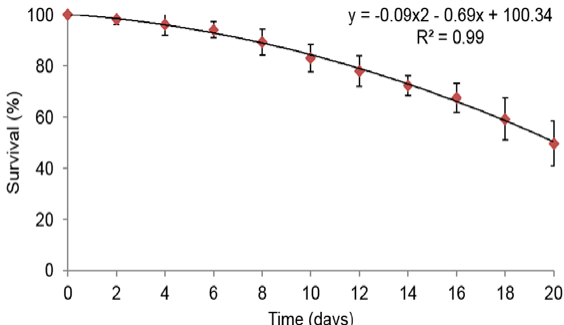
Fig. 5. – Cyprid survival (%; mean±SD) according to time in culture. Monitoring was done at two-day intervals for a period of 20 days. The fitted curve (polynomial regression: y=–0.09x 2 +0.69x+100.34, x ϵ [0,20]; R 2 =0.99, F=1479.23, p<0.01) for the present data is also